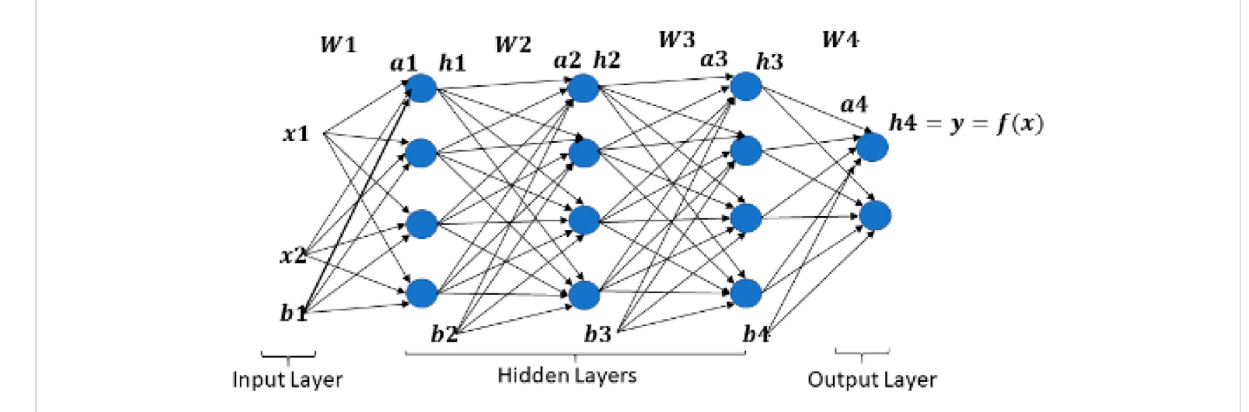
FIGURE 2 Interconnections of the designed network.